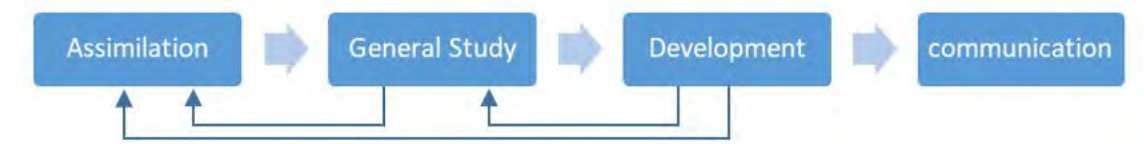
Figure 2. a map of the design process according to RIBA Architectural practices (Moughtin, Cuesta, Sarris, & Paola, 1999)